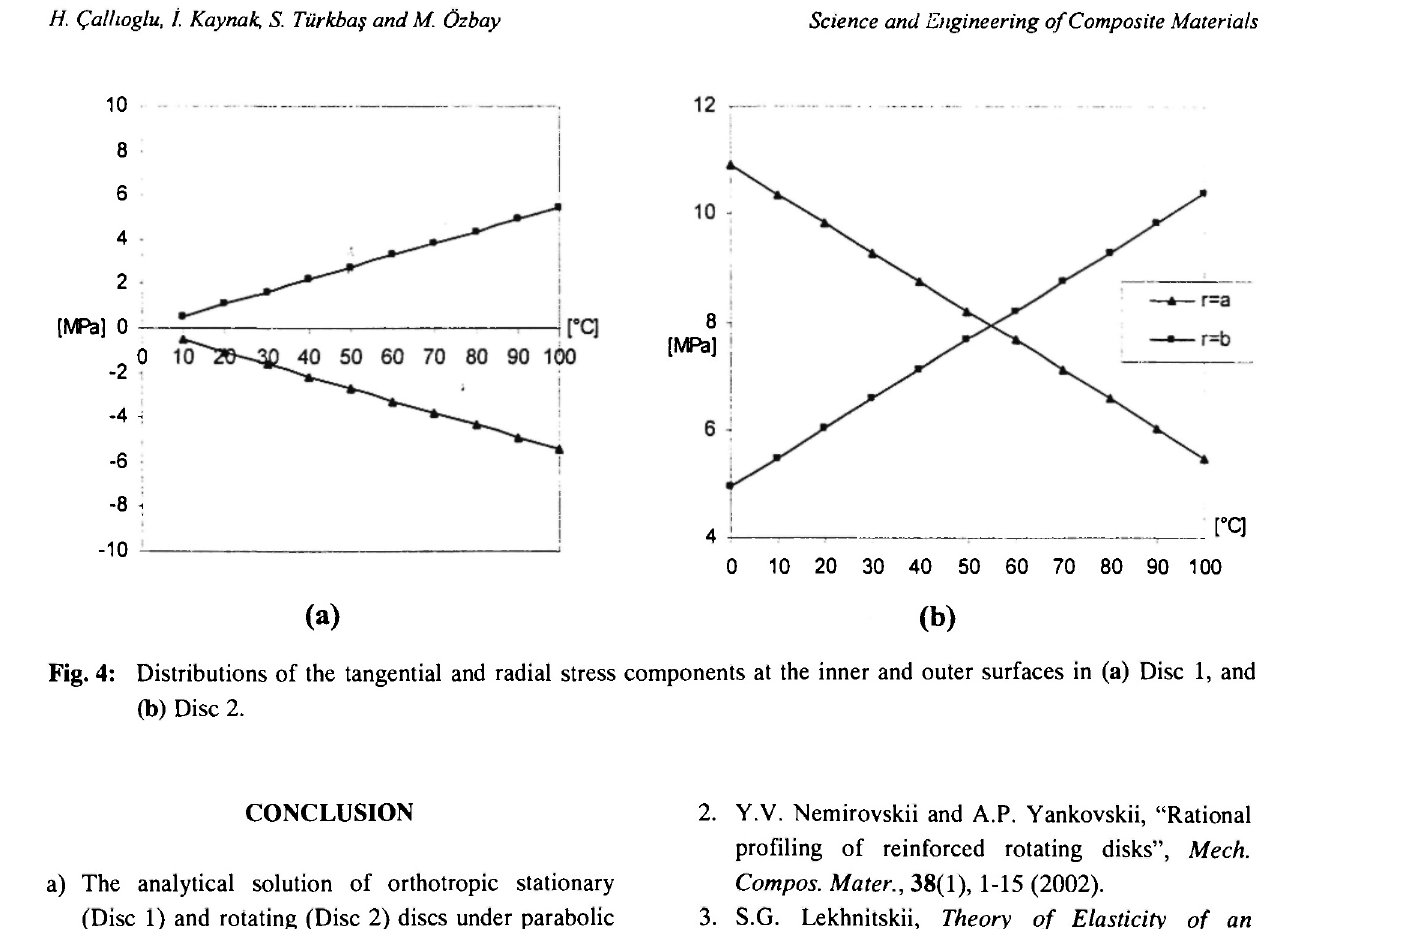
Fig. 4: Distributions of the tangential and radial stress (b) Disc 2.